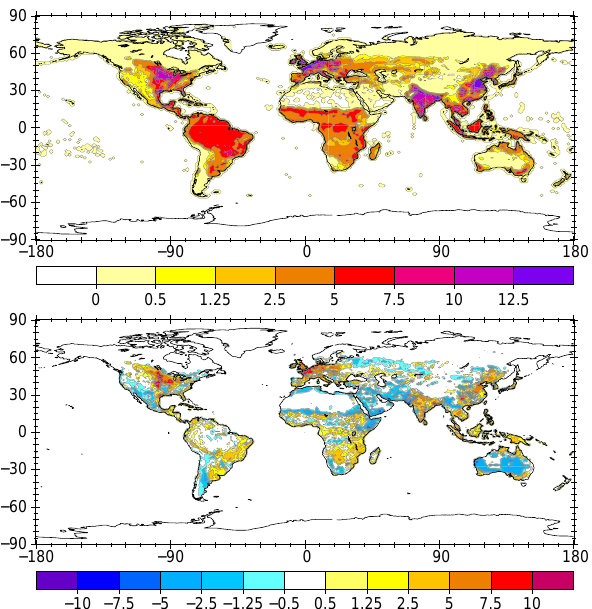
Fig. 5. Averaged SNO x flux in the whole simulation period (in ngm − 2 s − 1 ) for the LC simulation (upper panel) and the change compared to the YL95EMAC simulation (lower panel).